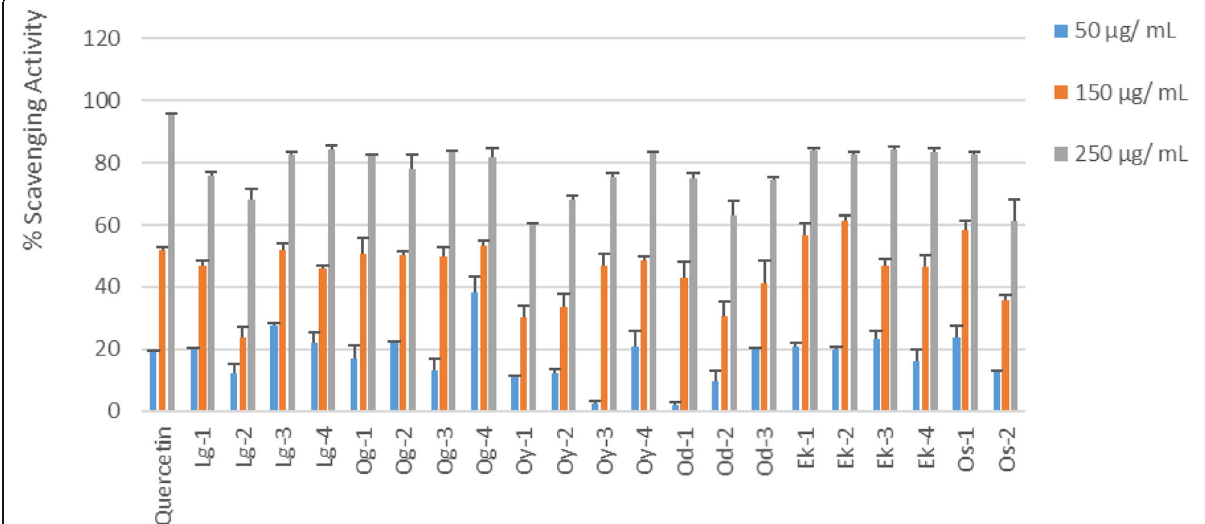
Fig. 7 Nitric oxide radical scavenging activity of Moringa oleifera leaf from the 21 locations. The results are mean of triplicates of three different concentrations (50 μ g/mL, 150 μ g/mL and 250 μ g/mL) with the error bars (standard deviation). The chart shows significant between- and within- group differences in the nitric oxide content of the samples from the locations. The nitric oxide radical scavenging activity of some locations compares well with the standard